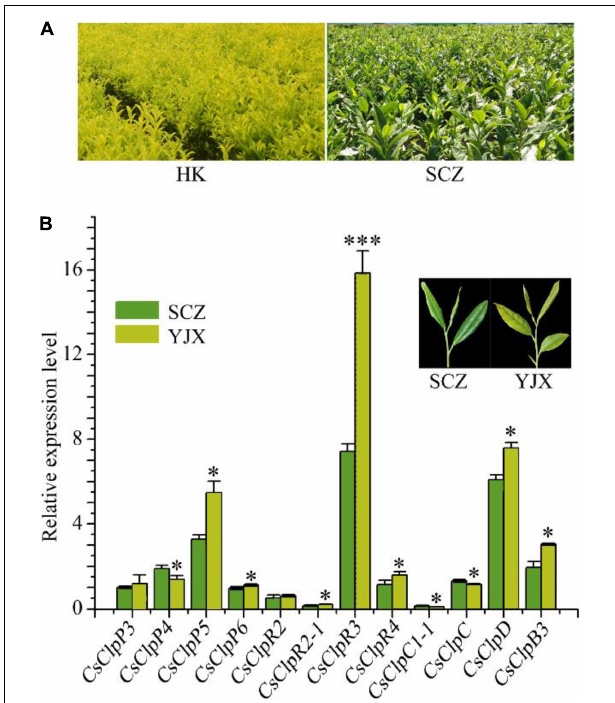
FIGURE 1 | Chlorotic tea garden and transcriptional alteration of the Clp complex genes in the chlorotic leaves of tea cultivar YJX compared with normal cultivar SCZ. (A) chlorotic tea garden of cv. ‘Huang-Kui’ (HK) compared with regular green leaf cv. ‘Shu-Cha-Zao.’ (B) Transcriptional alteration of the Clp complex genes in the chlorotic leaves of tea cultivar YJX compared with normal cultivar SCZ. YJX, ‘Yu-Jin-Xiang’; SCZ, ‘Shu-Cha-Zao.’ Statistical analysis using Student’s t -test was performed in at least triplicate using SPSS19 software. ∗ p < 0.05; ∗∗∗ p <